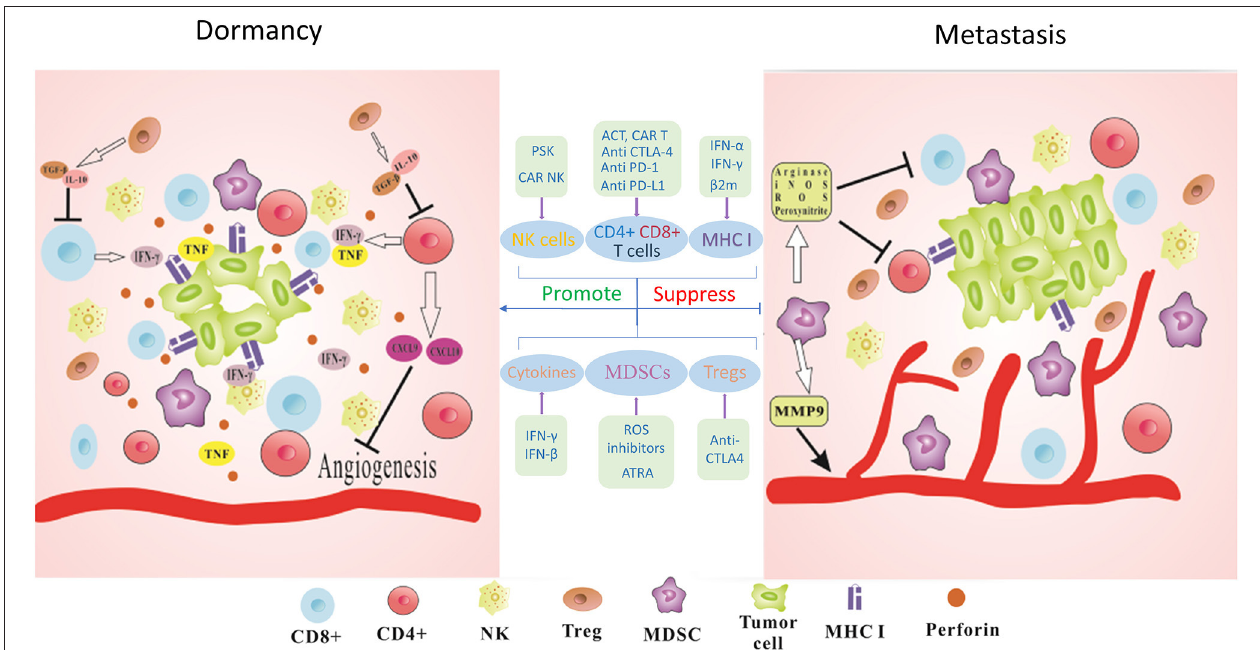
FIGURE 1 | Immune-mediated dormancy. The maintenance of functional dormancy in tumor cells requires the combined action of many immune factors. IFN- γ and TNF derived from T cells could directly regulate cell cycle progression of tumor cells and establish the dormant state. CD4 + T cells released antiangiogenic chemokines CXCL9 and CXCL10 leading to reduced angiogenesis and antitumor effects. Perforin-mediated cytotoxicity of NK cells also keeps tumor cells in dormant state and prevents the outgrowth of metastasis. MHC I surface expression on tumor cells could be also involved in this process. Furthermore, immunosuppressive cytokines such as TGF- β or IL-10 produced by Tregs could lead to decreased activity of T cells. MDSCs act as potent suppressors of T cells via the production of Arginase, iNOS, ROS, and Peroxynitrite. MDSCs could secret MMP9 to promote tumor angiogenesis and facilitate tumor development. Thus, blocking